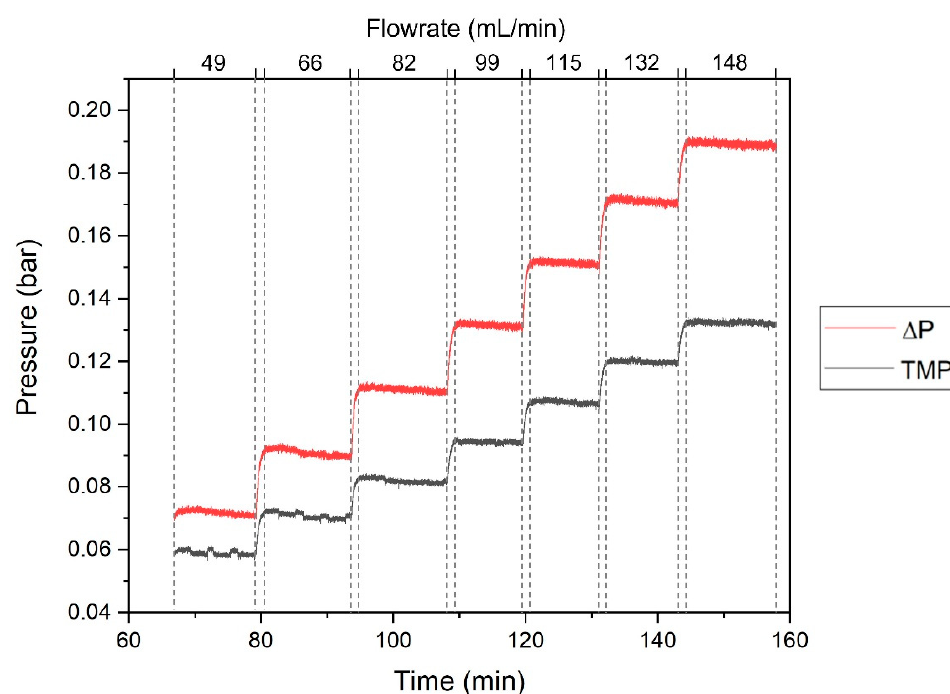
Figure 6. Δ P (red line) and TMP (black line) values obtained for the flow of DI water through the SHDMM circuit at different values of Q F , which are delimited by the dashed lines.